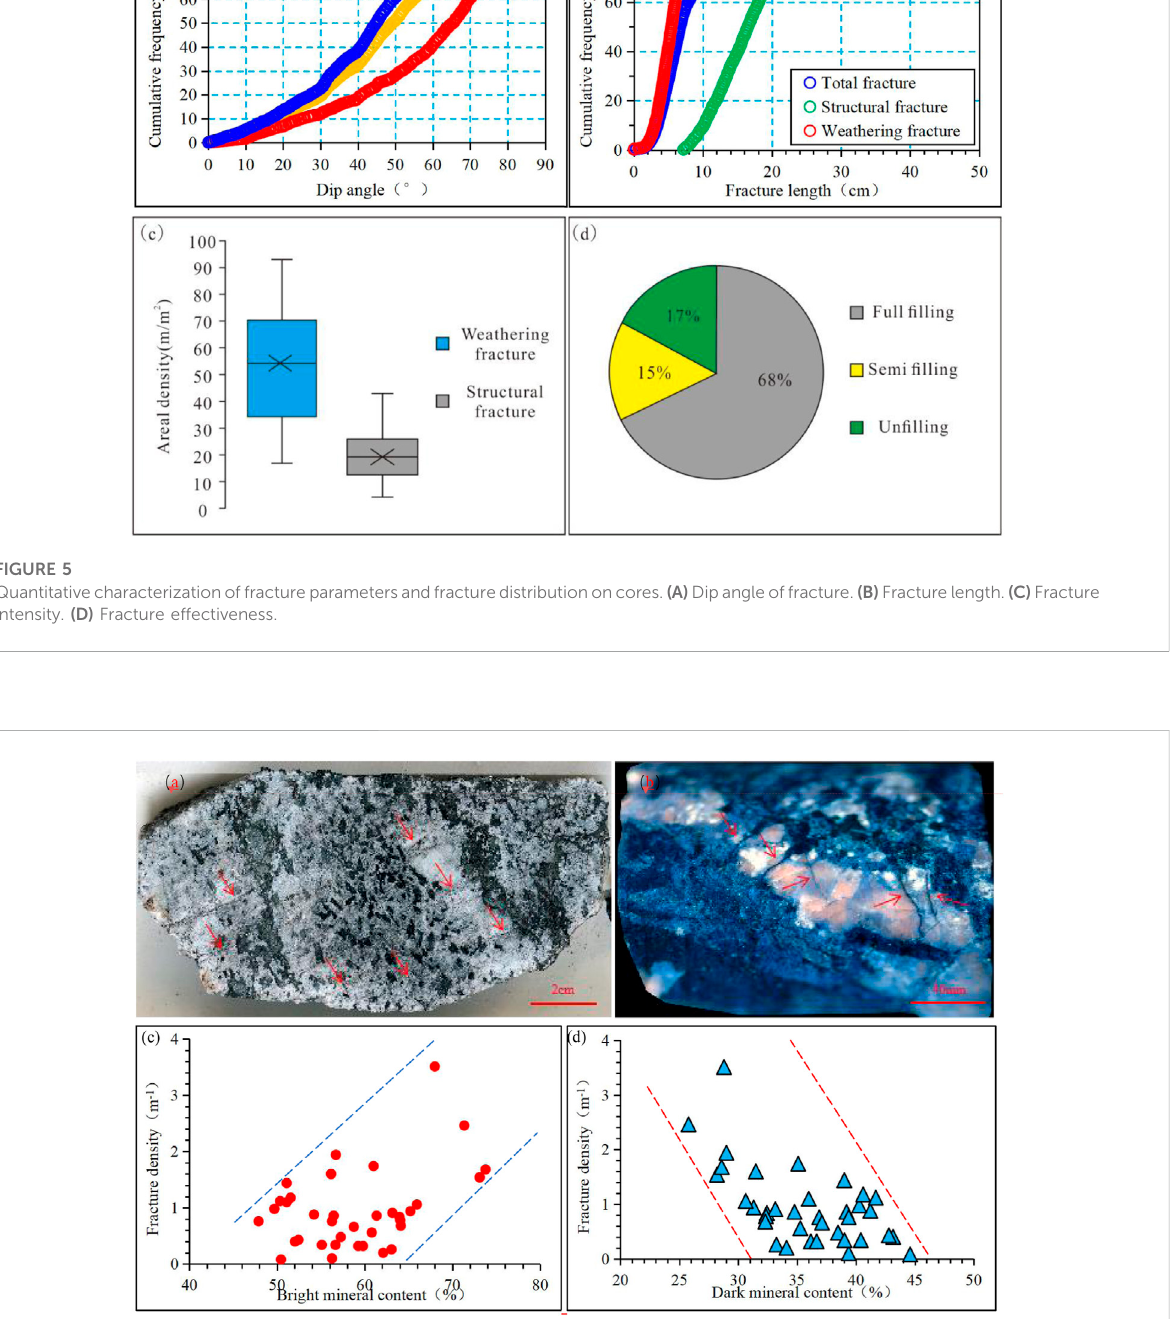
Frontiers in Earth